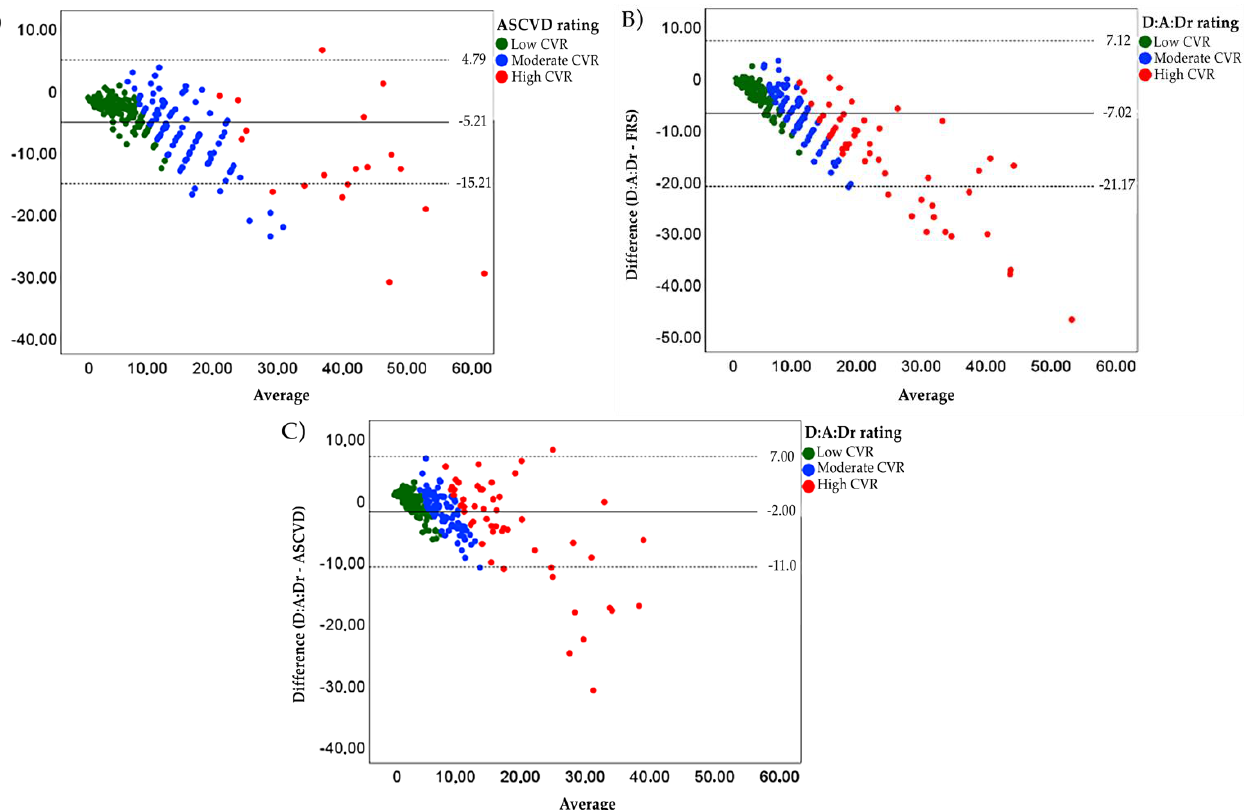
Figure 3. Bland-Altman plots comparing ASCVD, FRS and D:A:Dr. A) The ASCVD risk score was on average 5.21% (±5.00%) lower than FRS; the limits of the difference were -15.21% and 4.79%. B)